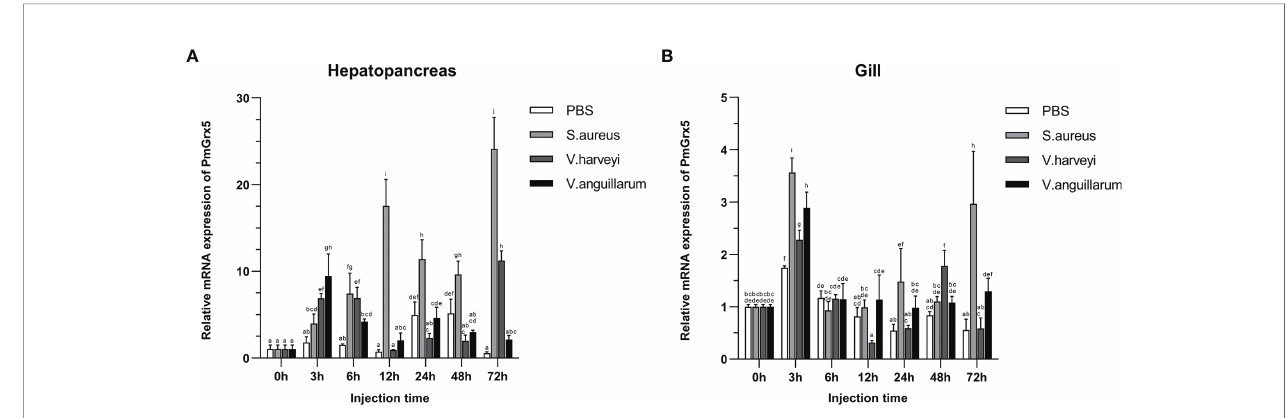
FIGURE 6 | mRNA expression levels of PmGrx5 in the hepatopancreas (A) and gill (B) at different time intervals after multiple pathogenic bacteria injections. The data are presented as mean ± SD ( n = 3). Different letters denote signi fi cant differences ( P <